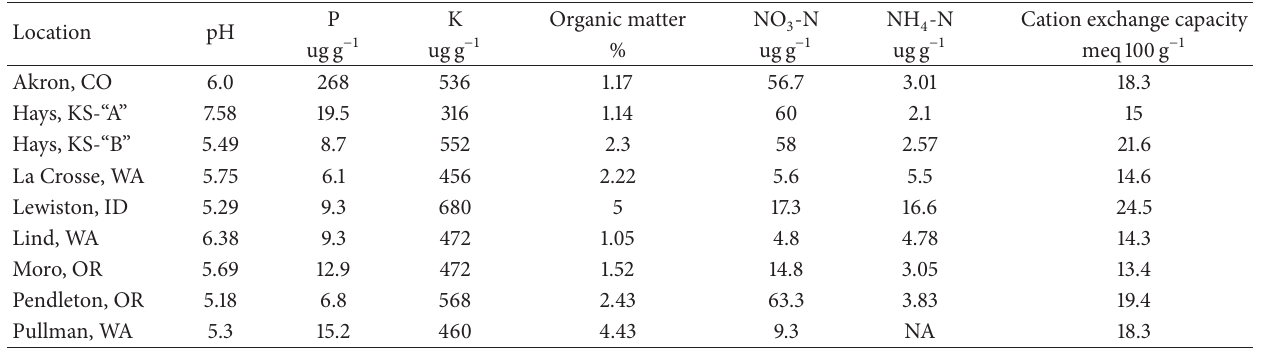
Table 1: Chemical properties of test soils used in P. fluorescens D7rif survival study.